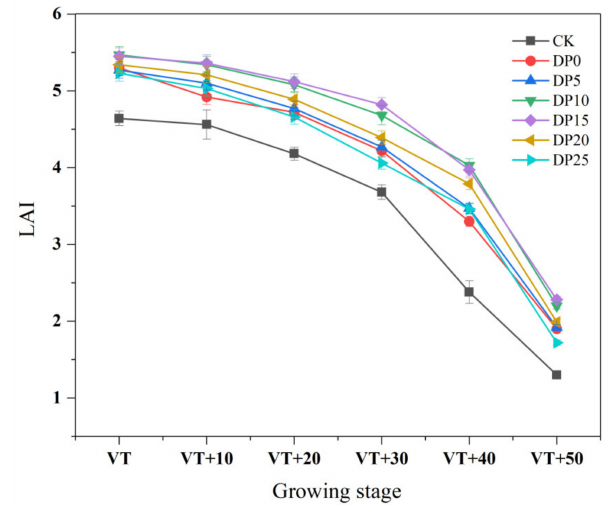
Figure 2. Effect of different basal application depths of controlled-release urea on leaf area index. CK: no fertilizer; DP0: surface application; DP5: fertilization depth 5 cm; DP10: fertilization depth 10 cm; DP15: fertilization depth 15 cm; DP20: fertilization depth 20 cm; DP25: fertilization depth 25 cm. Thin vertical bars are standard errors ( n = 15).